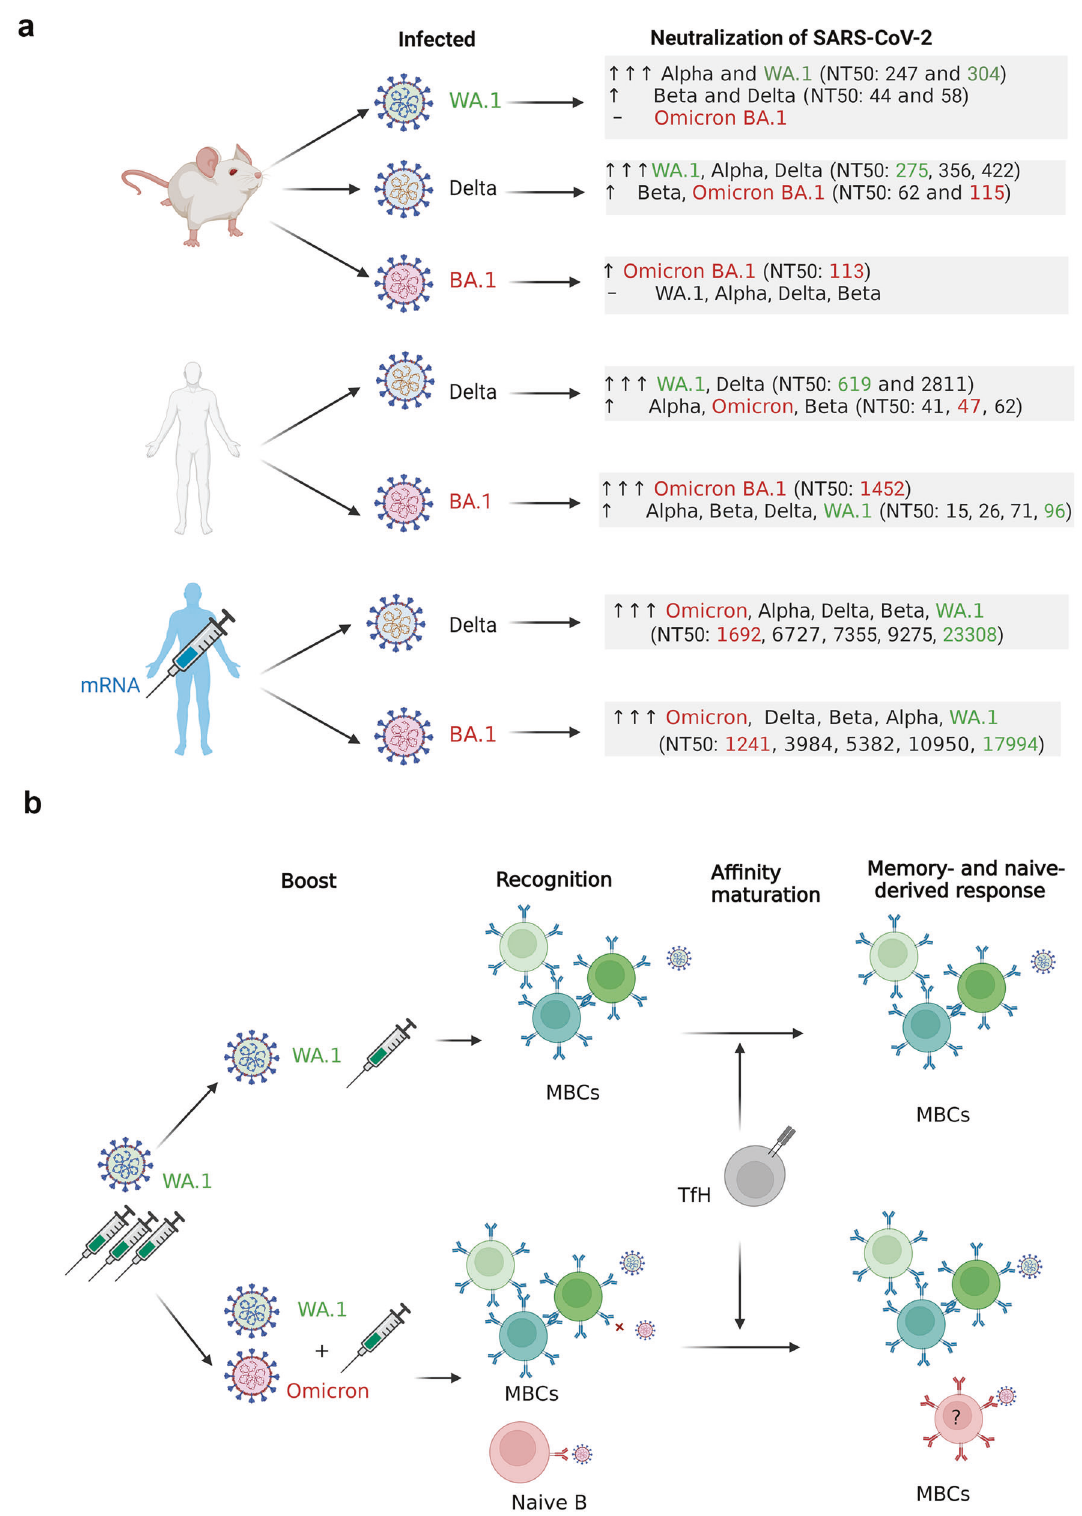
antibodies, and possibly facilitating the emergence of new mutants. 2 Omicron may thus evolve to escape the humoral immunity induced by BA.1 infection, suggesting that